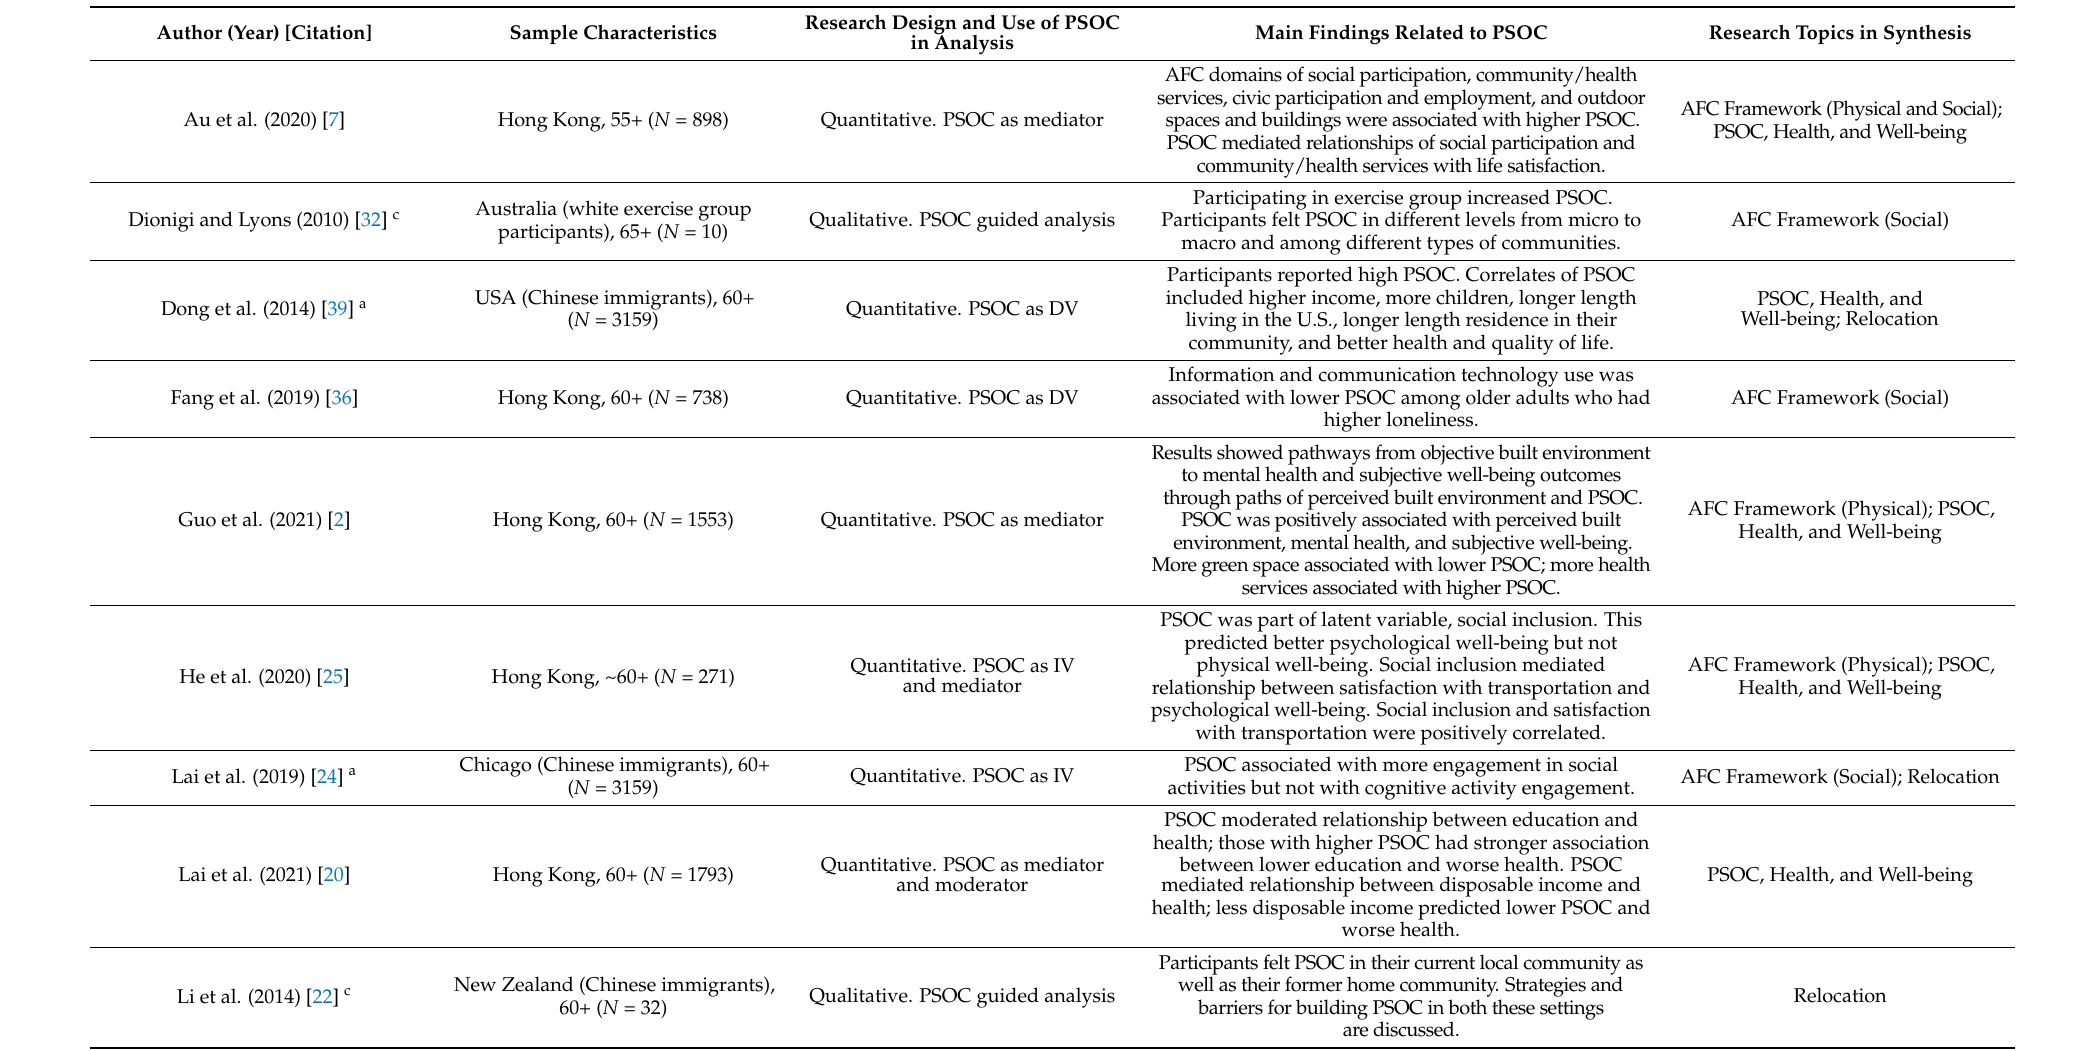
Table 1. Data Extraction and Charting for Articles in Final